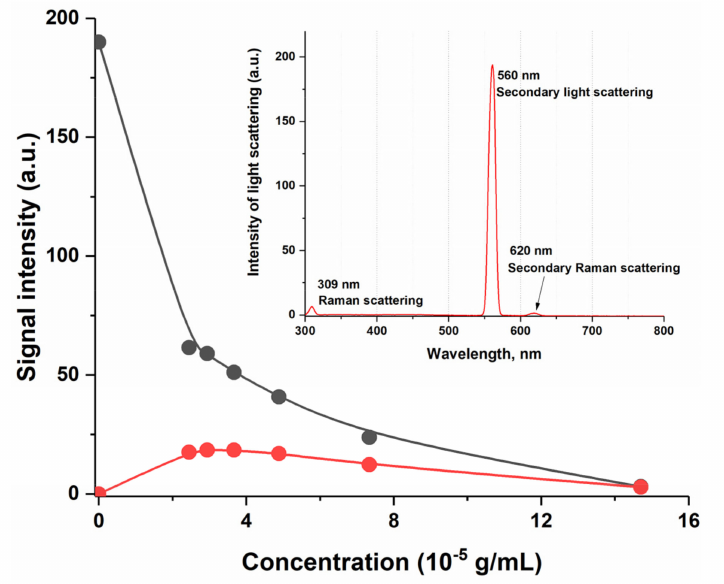
Figure 4. Dependence of the fluorescence signal at 460 nm (red line) and the second-order scat- tering signal at 700 nm (black line) depending on the concentration of the HC in an aqueous solu- tion, λ ex = 350 nm; the insert shows fluorescence/scattering spectrum of the HC with concentration 7.3 × 10 − 14 g/mL, λ ex = 280.